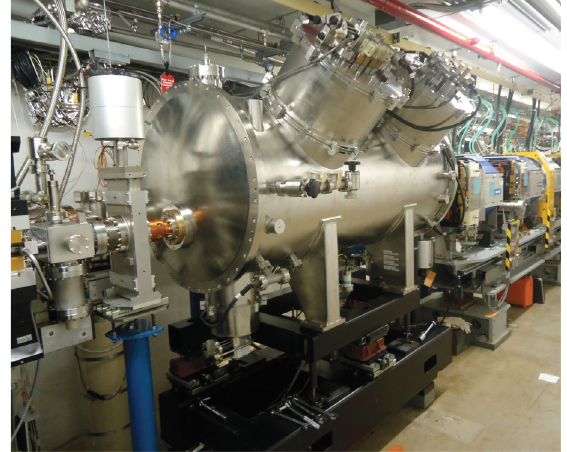
FIG. 13. Photograph of SCU0 installed into Sector 6 of the APS storage